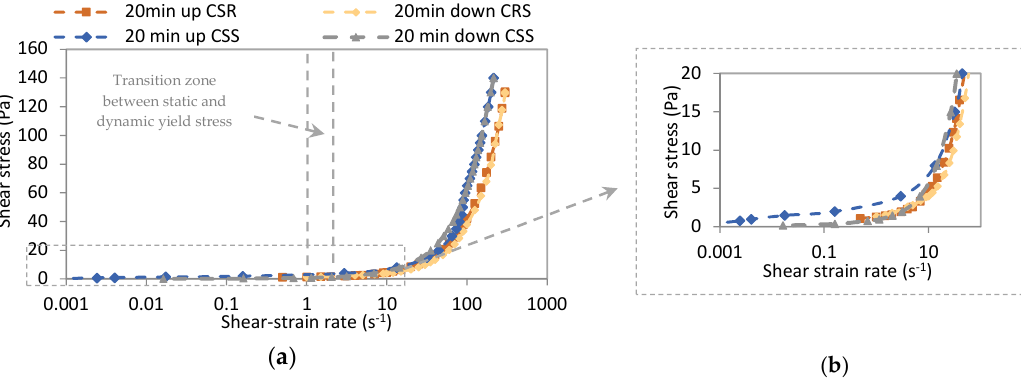
Figure 10. Flow curve obtained by CSS and CRS methods for grout with 0.03% PP fibers: ( a ) all shear-strain rate range; ( b ) focus on lower shear-strain rates.